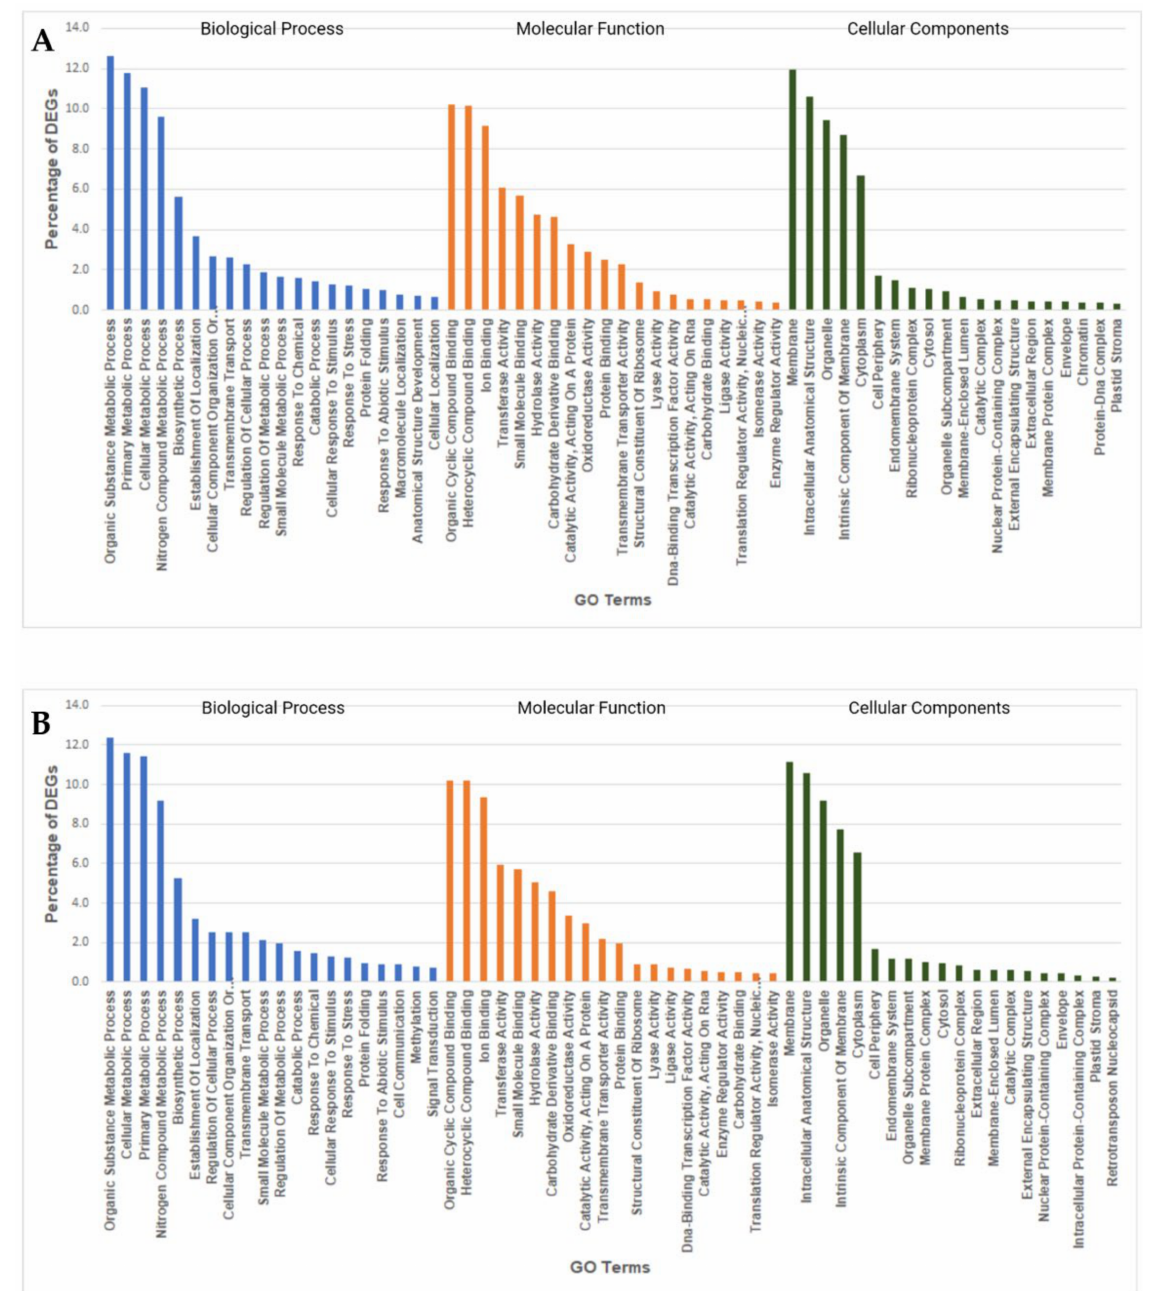
Figure 7. Gene ontology enrichment analysis of DEGs from V. darrowii . Highly enriched Gene Ontology (GO) terms among the DEGs from V. darrowii under 6-h heat stress ( A ) and 9-h heat stress ( B